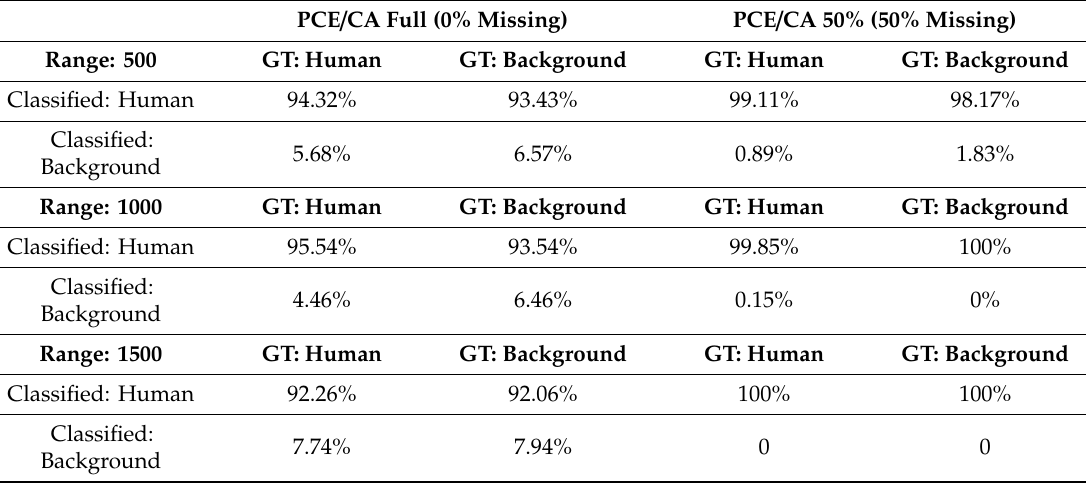
Table 4. ResNet classification results for MWIR videos in PCE